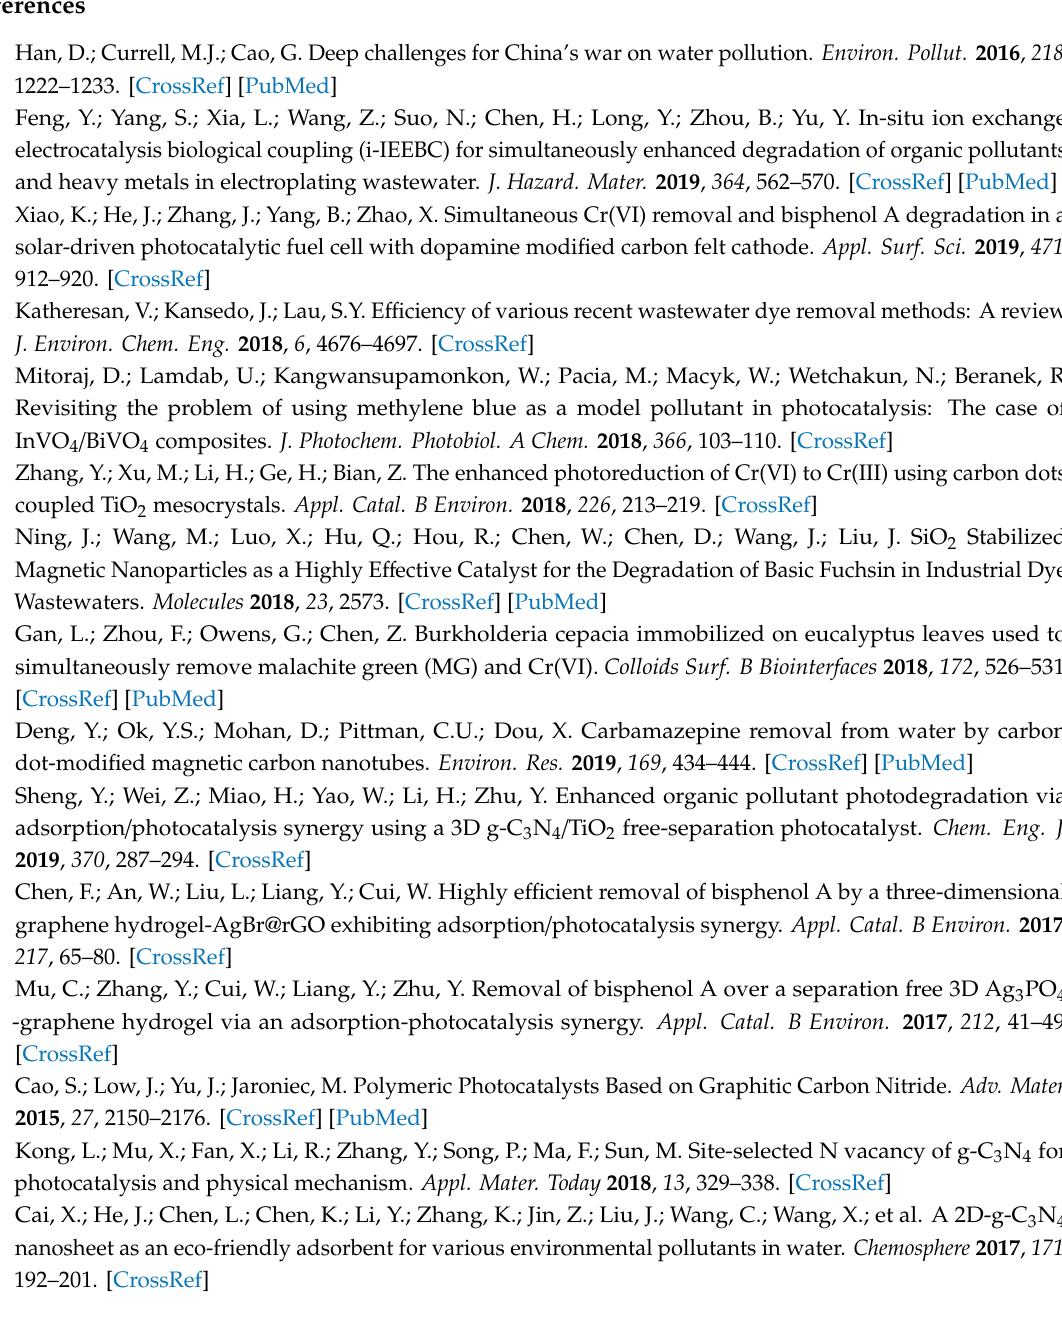
and CNBT; Figure S5: Hysteresis loops of BiFeO 3 , CNB, and CNBT measured; Figure S6: Comparison of the adsorption e ff ects of g-C 3 N 4 , BiFeO 3 , CNB, and CNBT: C 0Cr(VI) = 5 mg / L, C 0MB = 20 mg / L, m / V = 2.5 g / L, pH = 2.0, T = 25 ◦